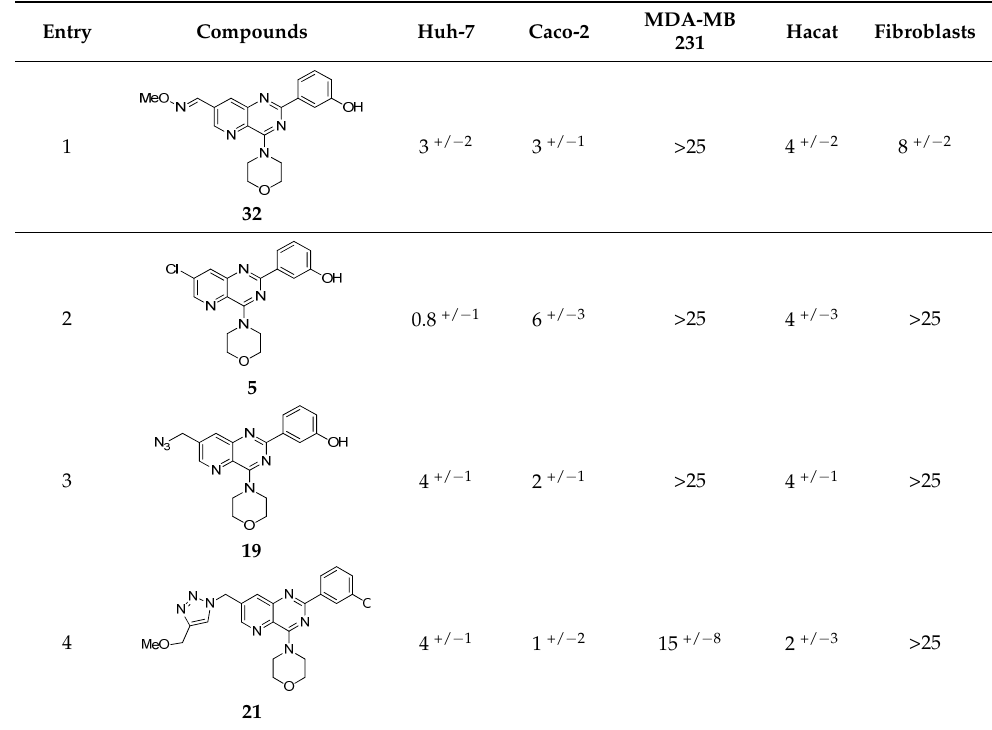
Table 3. In cell activity of the best compounds, IC 50 ( μ M) a .